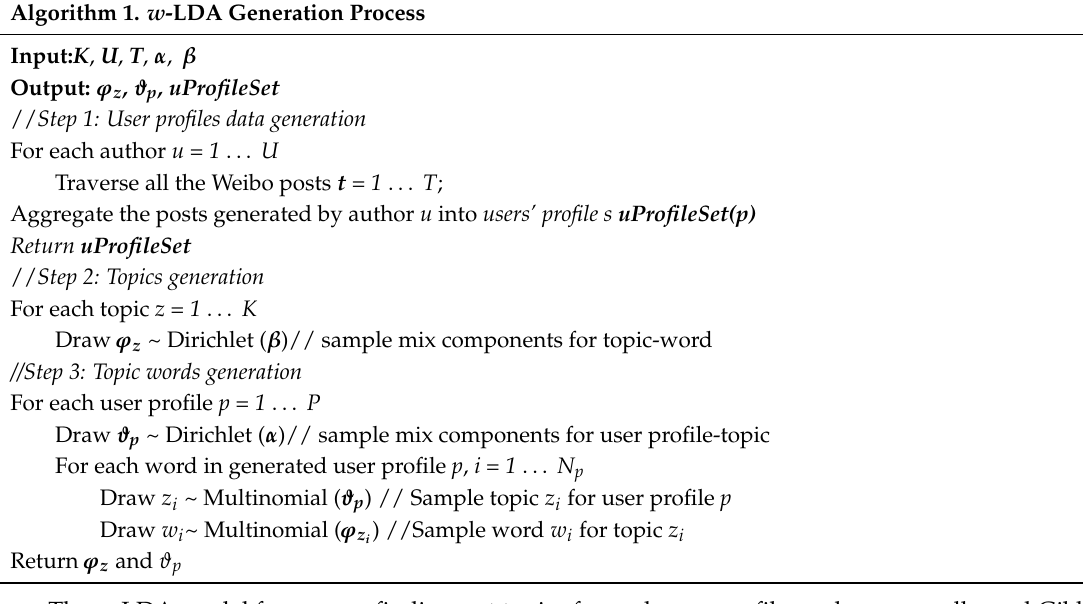
Algorithm 1. w -LDA Generation